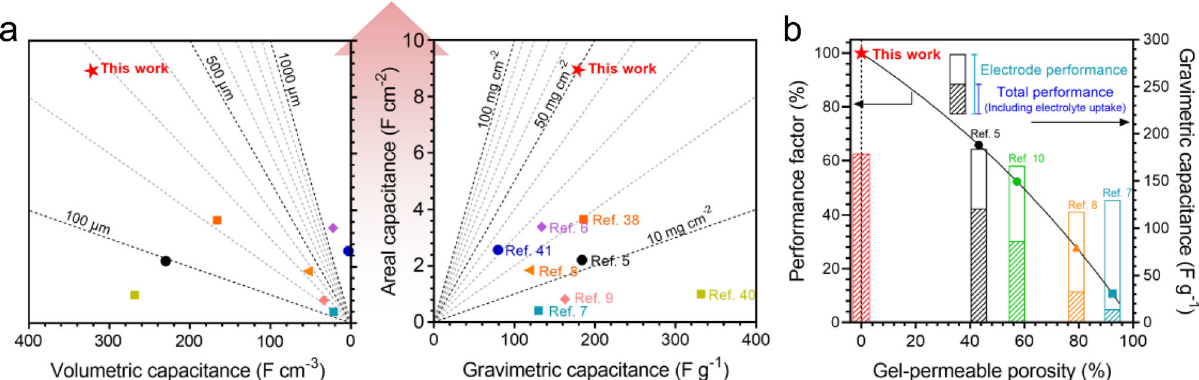
Fig. 4 Benchmarking of nano fl uidic electrode in gel electrolyte. a The holistic comparison of areal capacitance versus volumetric and gravimetric capacitances between nano fl uidic electrode (this work) in gel electrolyte and gel-in fi lled porous electrodes 5 – 9,38,40,41 (Supplementary Table 1). b Projection of the gravimetric capacitance of electrode in ( a ) when the mass of in fi lled gel electrolytes is included to account for the total mass accommodated by the volume of electrode. The resource data and calculation methods are detailed in Supplementary Tables 2 and 3. The theoretical density (1.5 g cm − 3 ) of a model gel electrolyte (H 2 SO 4 /PVA) was used in the translation 40